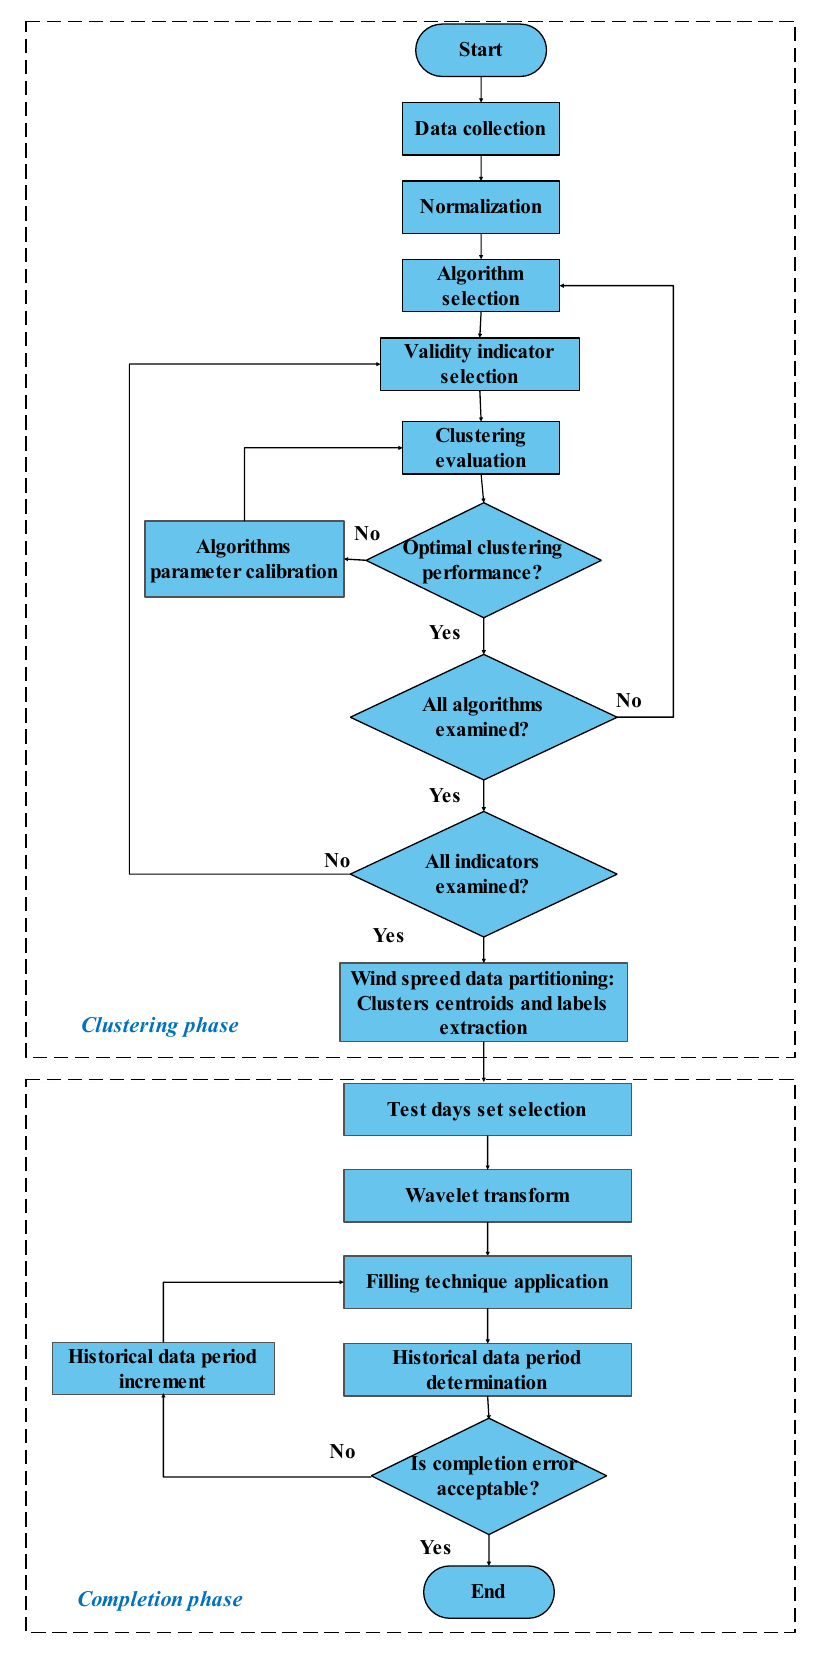
Figure 2. Flow-chart of the methodology of missing data filling.